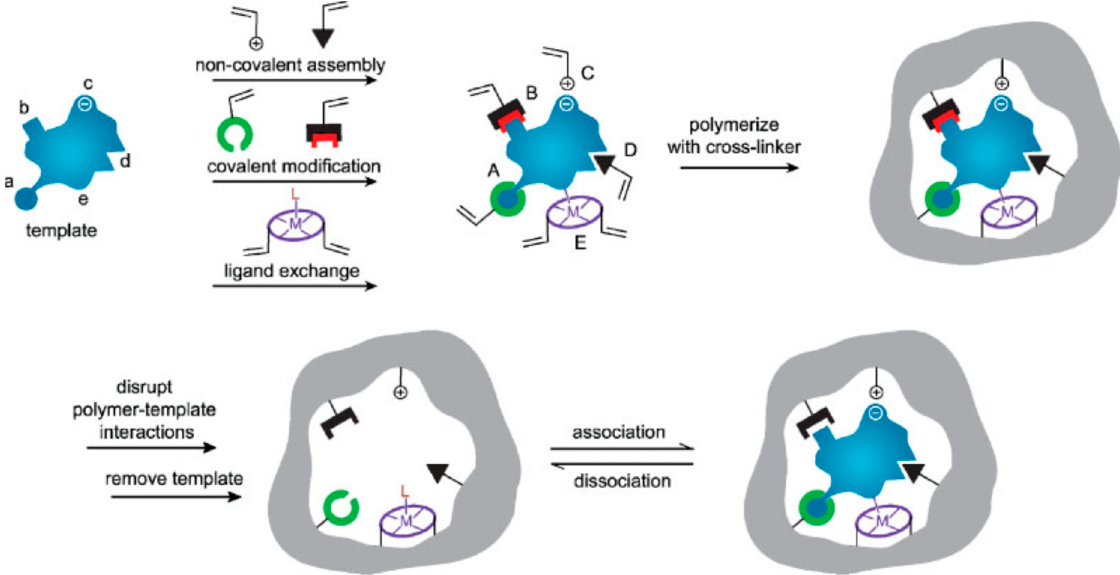
Figure 2. The principle of molecular imprinting recognition. Republished with permission from [42]; permission conveyed through the Copyright Clearance Center, Inc.